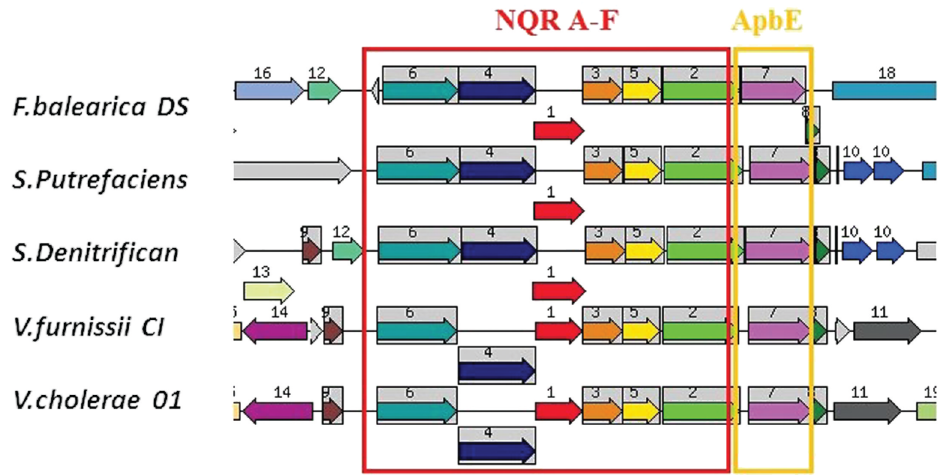
Figure 6: Example of genomic regions containing nqr A-F gene cluster and apbE orthologs retrieved from SEED database. Seed gene: nqrC, Ferrimonas balearica DSM (9799fig|550540.3.peg.901); e-20 similarity thresholds set for region